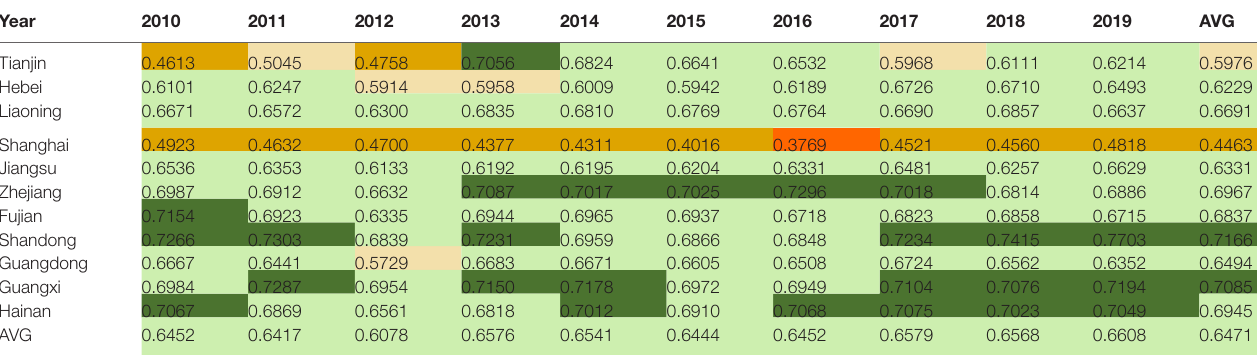
TABLE 4 | The coupling coordination of marine capture fisheries in 11 coastal areas of China.